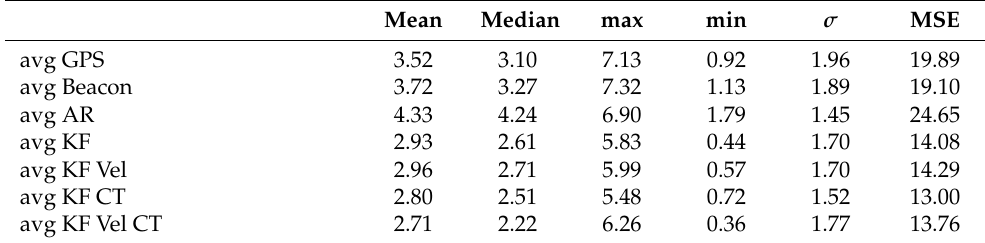
Table 12. Evaluation (Dataset 2): GPS, beacon, and AR; distance to correct point on the ground truth.